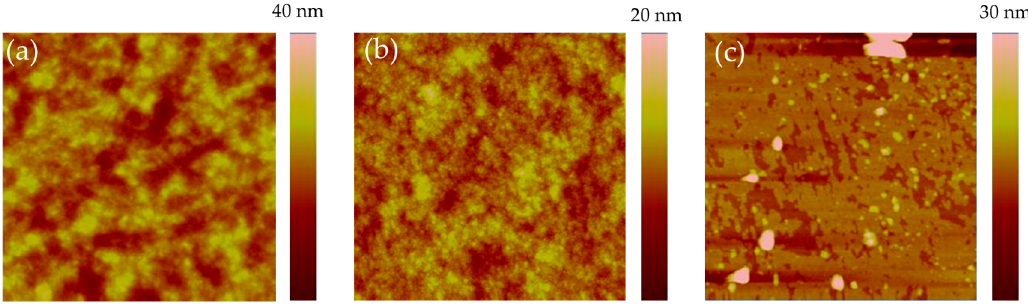
Figure 4. AFM height images (3 × 3 μ m 2 ) of ( a ) ITO, ( b ) DMAPA-C 60 -decorated ITO, and ( c ) ZnO-decorated ITO.